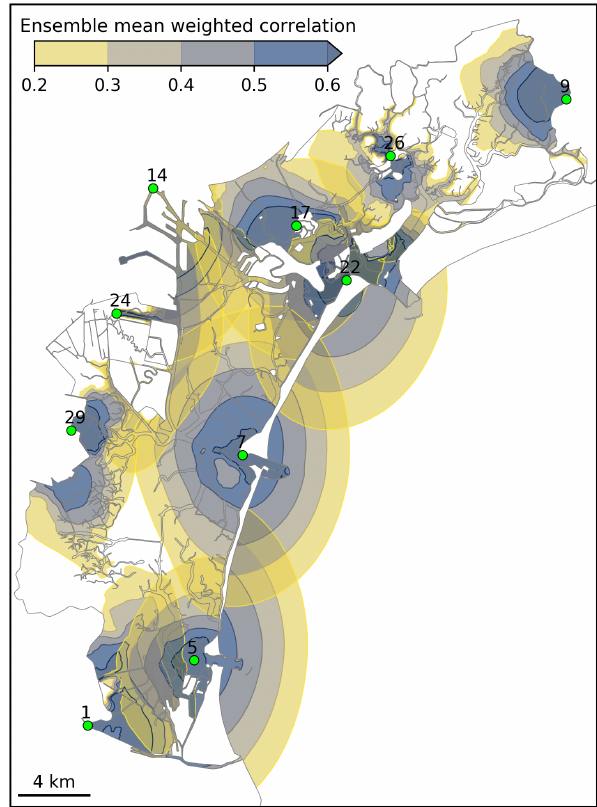
Figure 9. Ensemble weighted correlation (averaged over the simu- lation period) of the 10 monitoring stations selected using the En- SRF